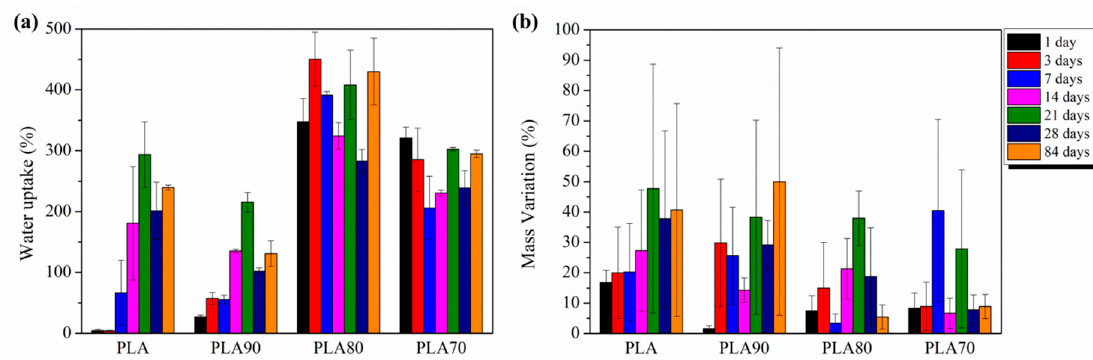
Figure 12. ( a ) Water uptake (%) and ( b ) mass variation (%) for neat PLA and each of the PLA:OLA electrospun samples after different amounts of days of immersion in PBS.